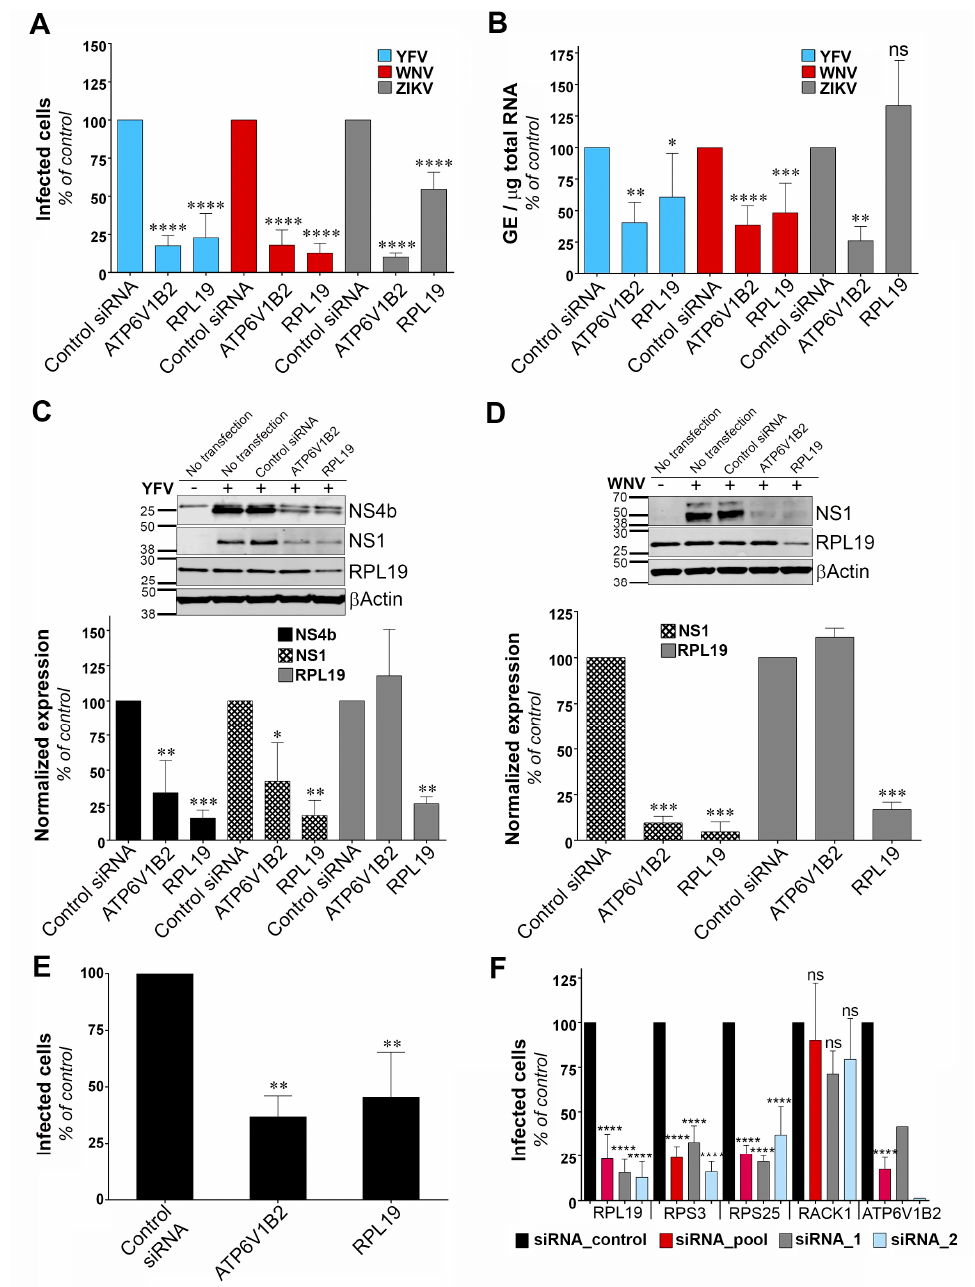
Figure 4. Ribosomal protein L19 (RPL19) is required for YFV and WNV viral protein synthesis. (A) HeLa cells were transfected with siRNA targeting RPL19 or ATP6V1B2 and infected 48 hours later with YFV, WNV, or ZIKV at an MOI of 1. The percentages of cells expressing the viral E protein were determined by flow cytometry analysis 24 h post-infection. Results are expressed as percent of E-positive cells and normalized to cells transfected with non-targeting control siRNA. (B) HeLa cells were transfected with siRNA targeting RPL19 or ATP6V1B2 and infected with YFV, WNV, or ZIKV 48 hours later at an MOI of 1. The relative amounts of cell-associated viral RNA were determined by qPCR analysis at 24 h post-infection. Amounts of viral RNA are expressed as genome equivalents (GE) per μ g of total cellular RNA and normalized to the sample transfected with non-targeting control siRNA. (C-D) The level of viral protein was determined by SDS-PAGE and Western blotting 24 h after